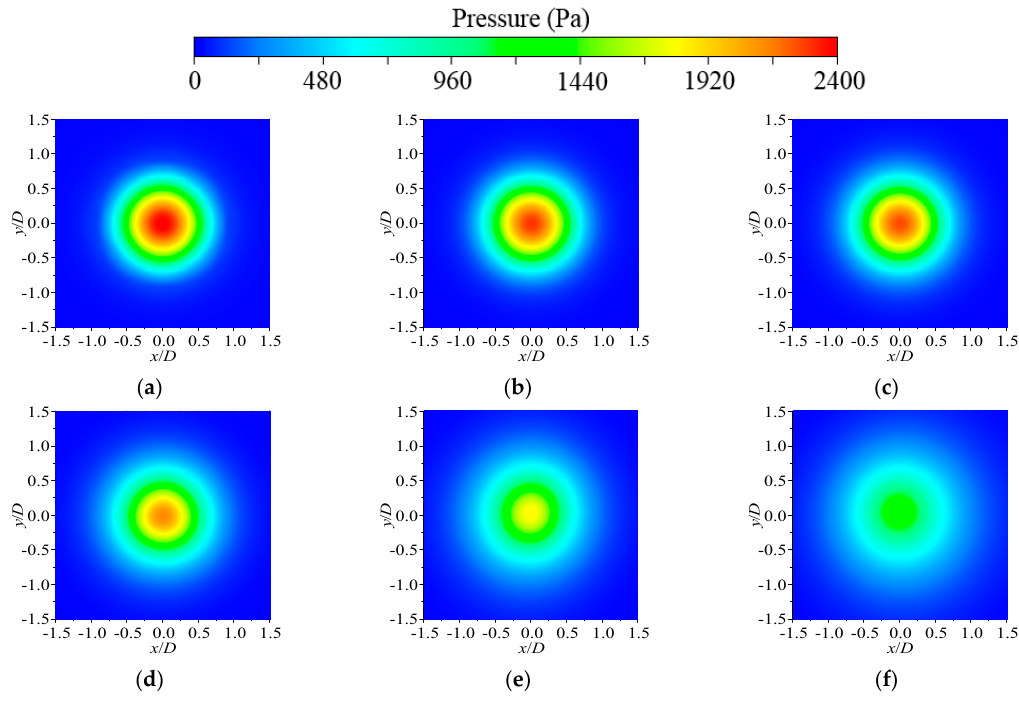
Figure 13. Variation of normalized maximum velocity V m / V b along the x direction.